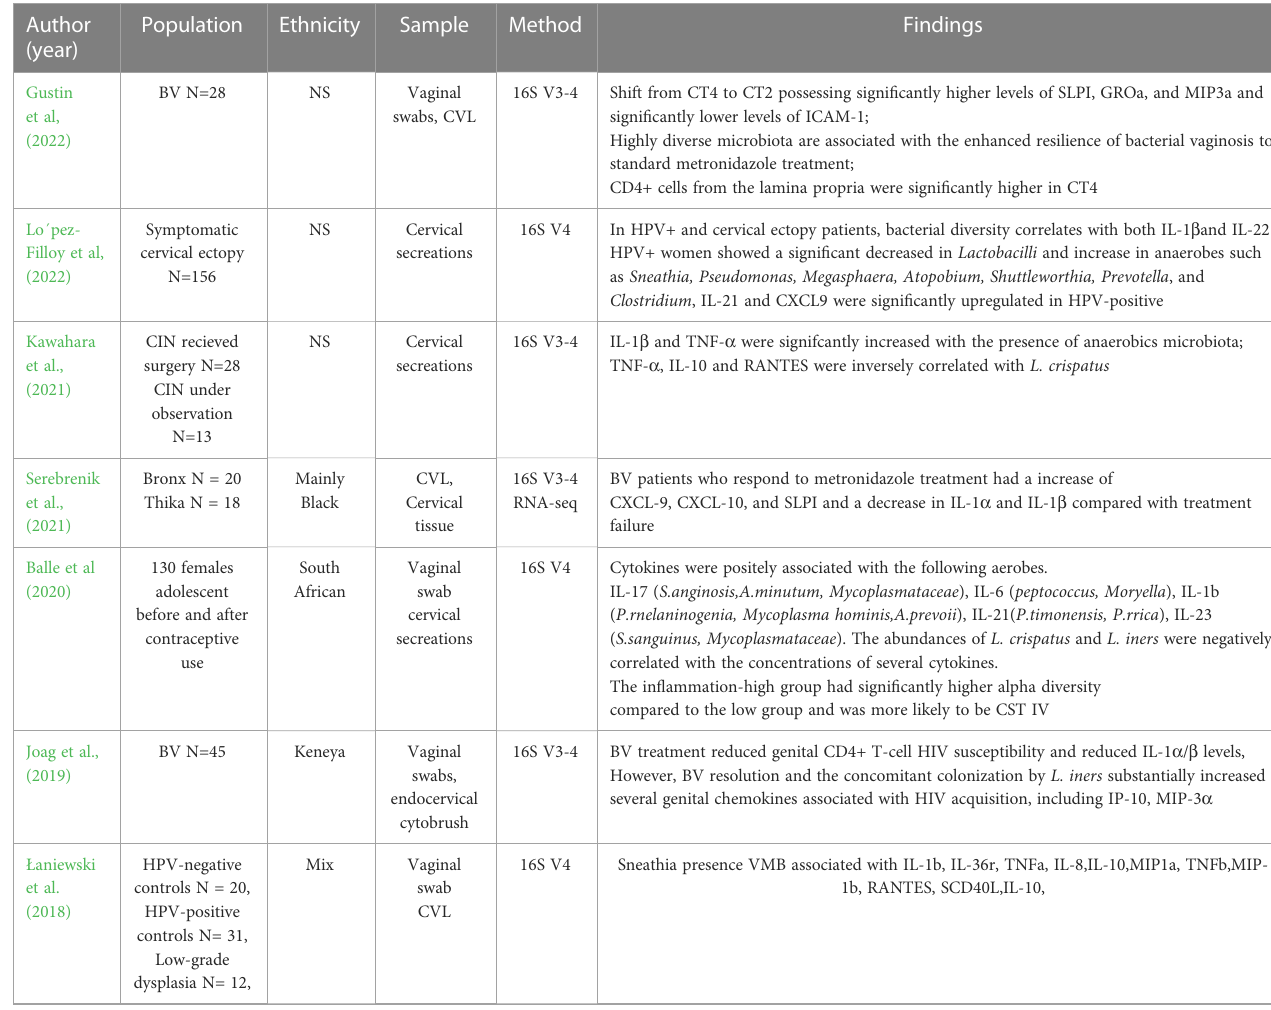
TABLE 1 The clinical studies of the relationship between cervical cytokines and CVM